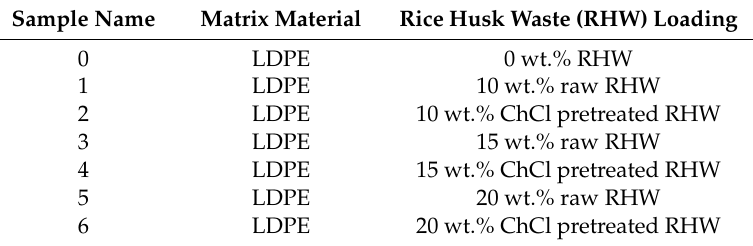
Figure 1. Schematic representation of biocomposite fabrication. Table 1. Raw and ChCl pretreated RHW loading (wt.%) in the low-density polyethylene (LDPE) matrix material, along with their sample ID.